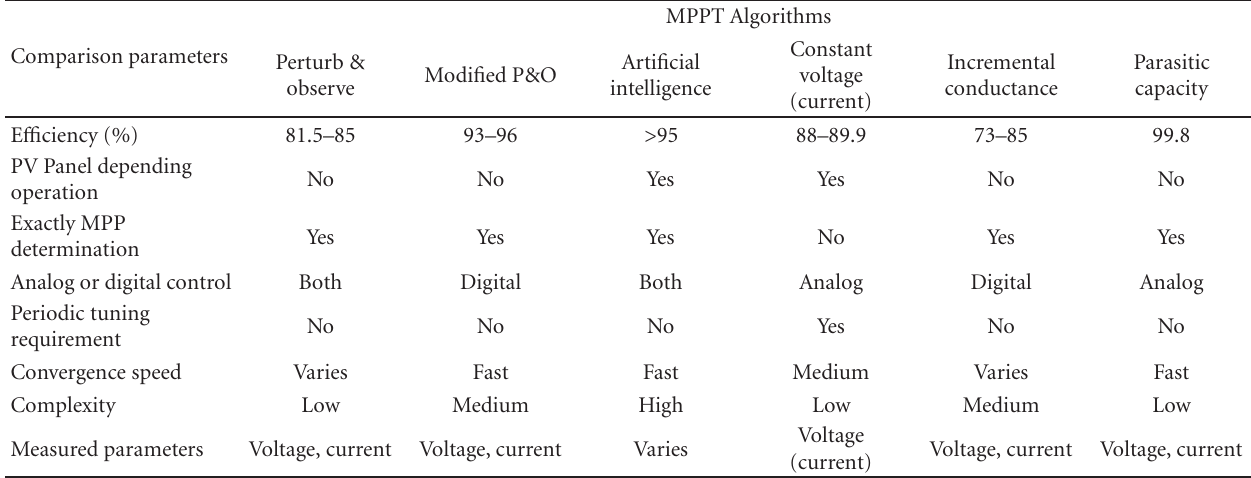
Table 1: Comparison of MPPT techniques according to several parameters [10, 28, 32,